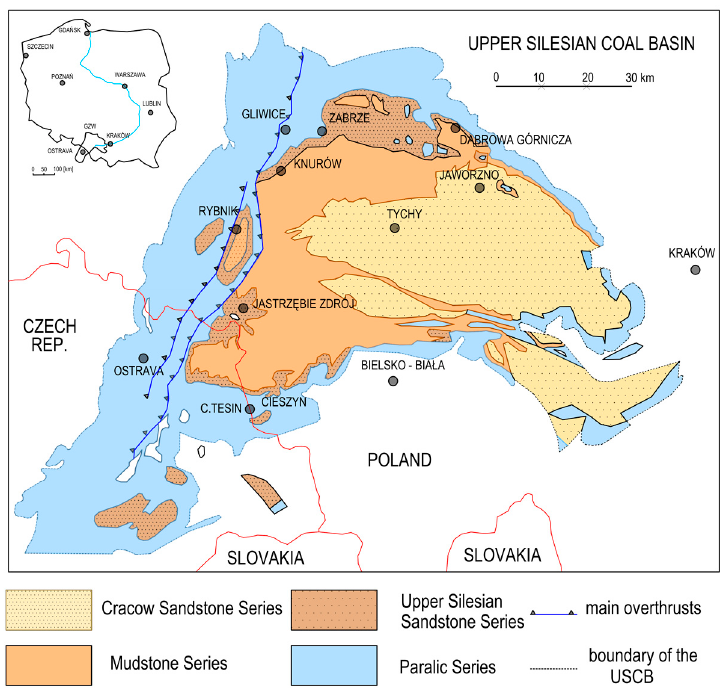
Figure 3. Location of the Upper Silesian Basin in Poland ([30,31]).